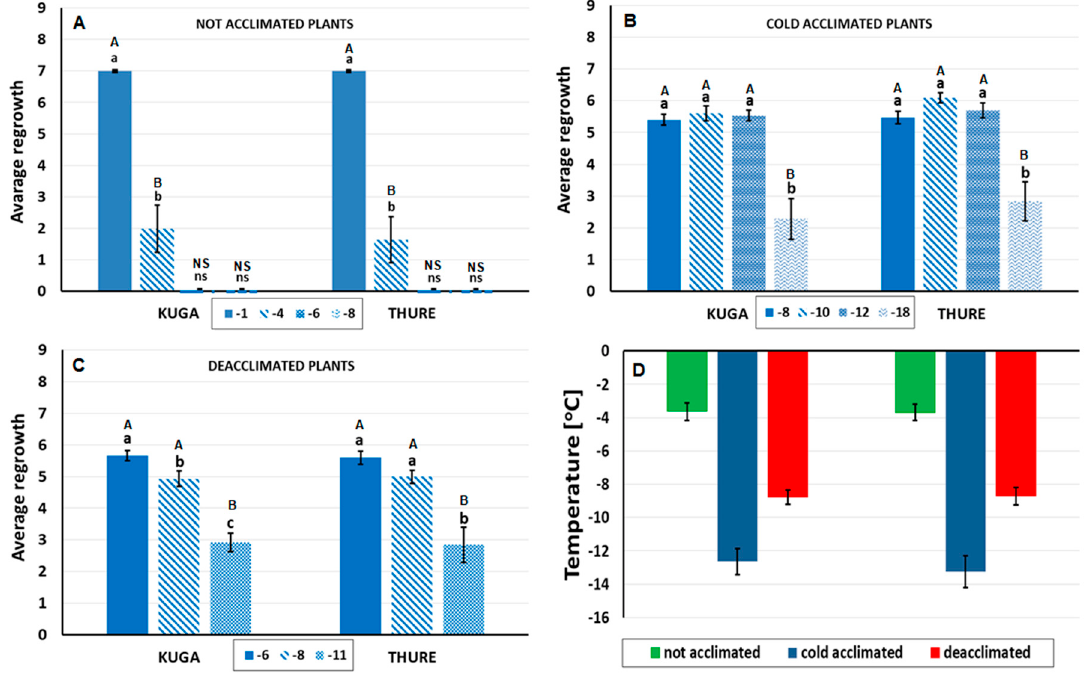
Figure 1. The frost tolerance of oilseed rape (cv. Kuga and cv. Thure) that characterised the not acclimated plants ( A ), cold-acclimated plants ( B ), and deacclimated plants ( C ). ( D ) Estimated temperature required to reduce plant regrowth by 50% (RT50). Mean values ± SD marked with the same letters (in Figure 1A–C) did not differ significantly at p ≤ 0.05 according to Duncan’s test, n = 15; lowercase—comparison separately within each cultivar, uppercase—comparison between cultivars. The values in Figure 1D are presented as ± the coefficient interval for p = 0.05.